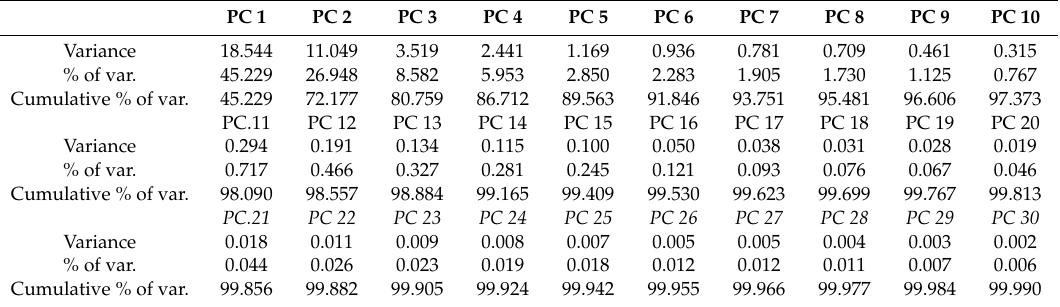
Table 6. Eigenvalues by